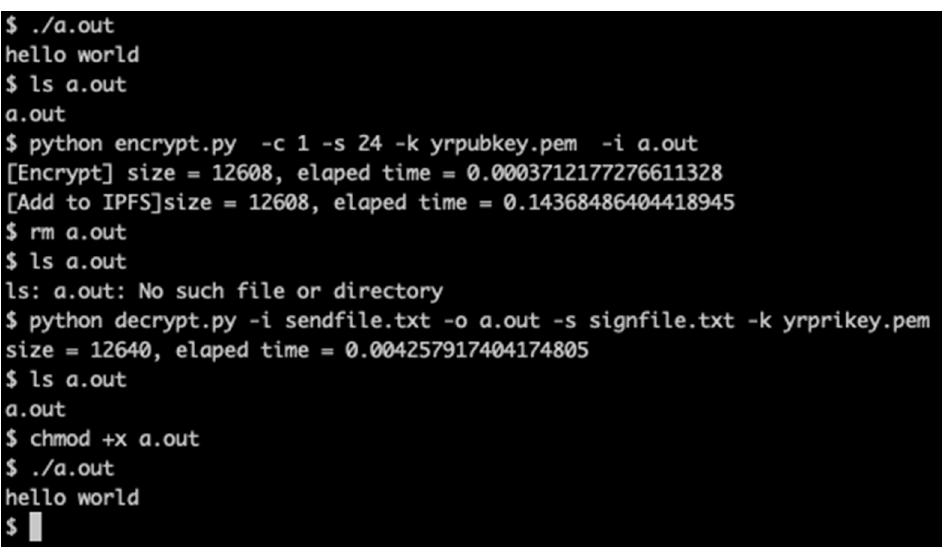
Figure 7. Testing of encryption and decryption of a file in SC-CDM.